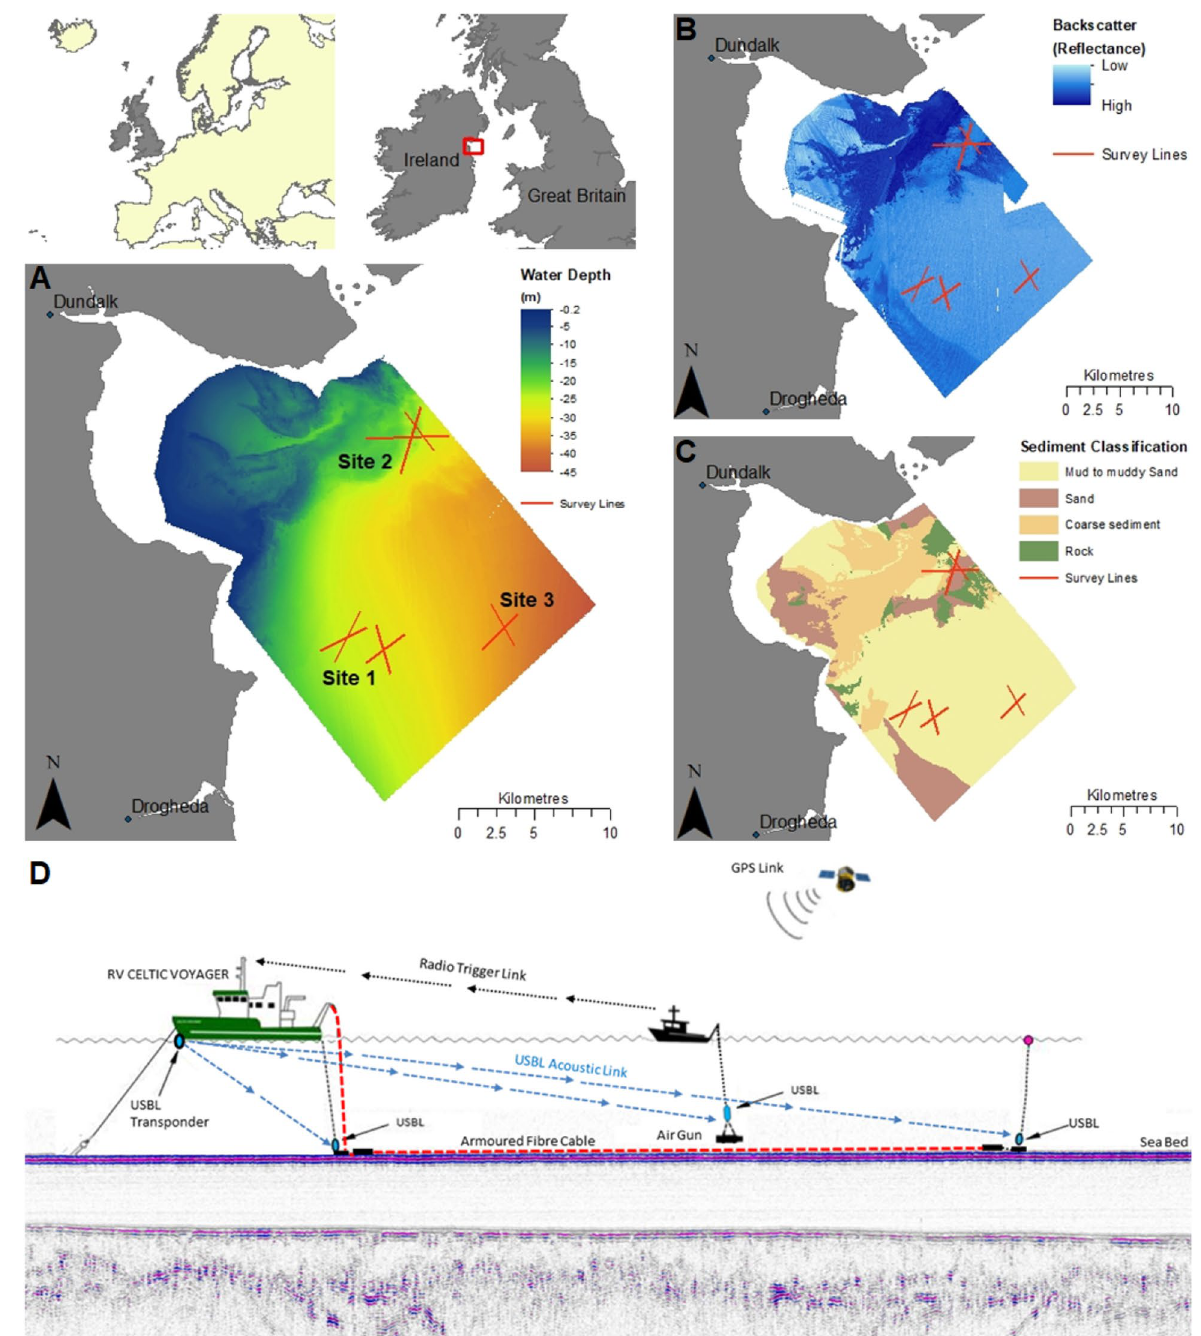
Figure 1. Site map showing ( a ) bathymetry derived from multibeam echosounder (MBES) data, ( b ) acoustic backscatter derived from MBES data, ( c ) sediment classification with test locations, and (d) schematic view of deployment methodology overlaid on high resolution sparker reflection data (Not To Scale). MBES and sediment classification data is Irish Public Sector Data (INFOMAR) licensed under a Creative Commons Attribution 4.0 International (CC BY 4.0) licence and accessed through https:// www. infom ar. ie. The maps were generated using ArcGIS Desktop v10.7 (www. arcgis.